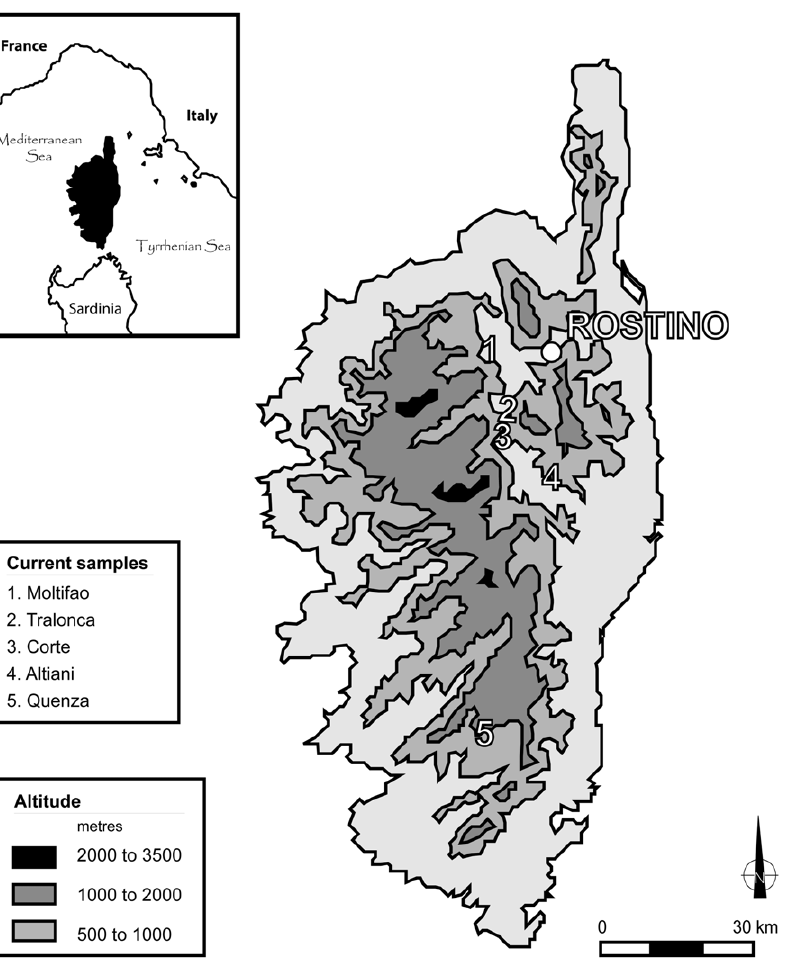
Figure 1. Ancient and present-day sampling of goats in Corsica. The medieval samples are all located in the archeological site of Rostino, in the northern part of the island. The present-day samples come from 5 different localities identified by numbers on the